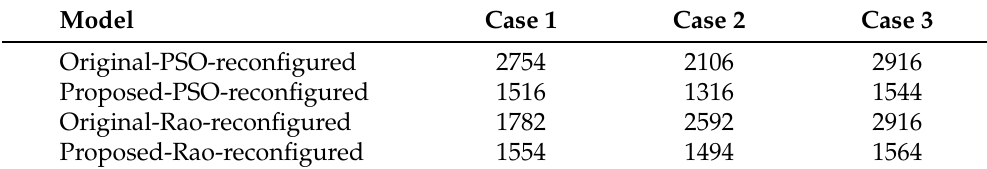
Table 6. Summary total number of switching times of PV array with time